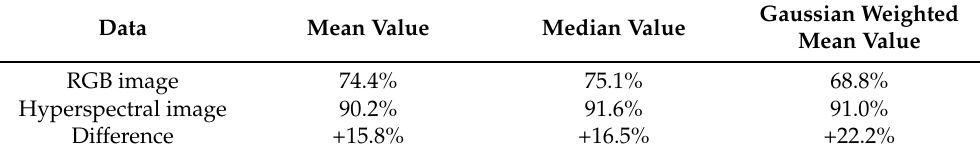
Table 2. The performance comparison of RF (random forest classifier)